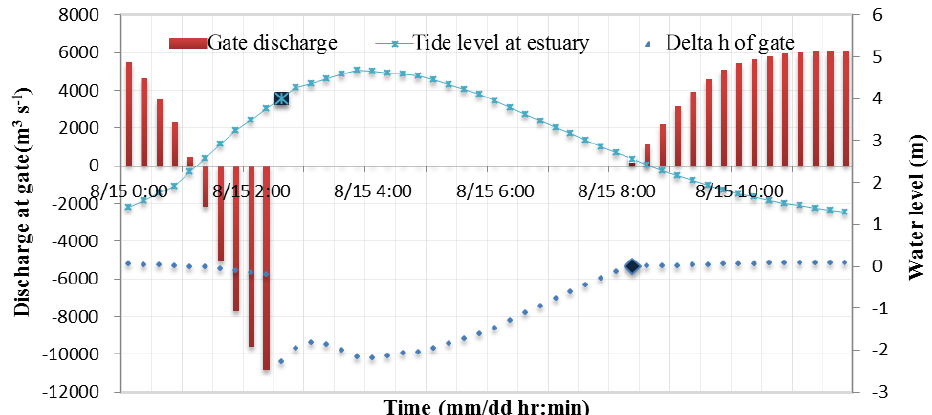
Figure 6. A test example when the gate needs to be closed due to the high water being higher than the tide threshold in this tidal period (a negative discharge indicates the tidal water intrusion).